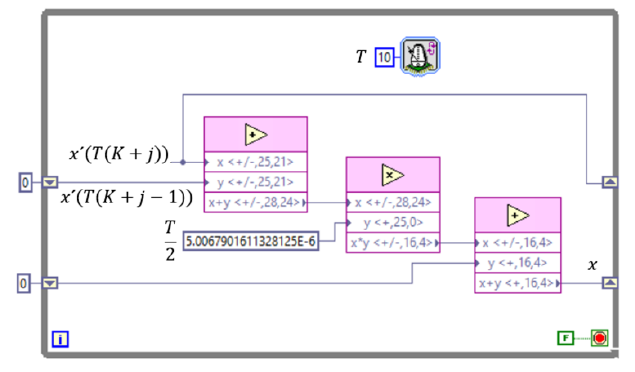
Figure 11. Algorithm for calculating the integral.